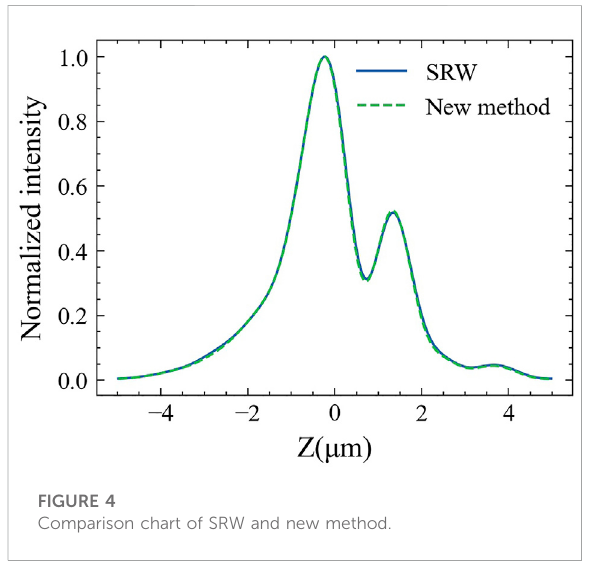
FIGURE 4 Comparison chart of SRW and new method.